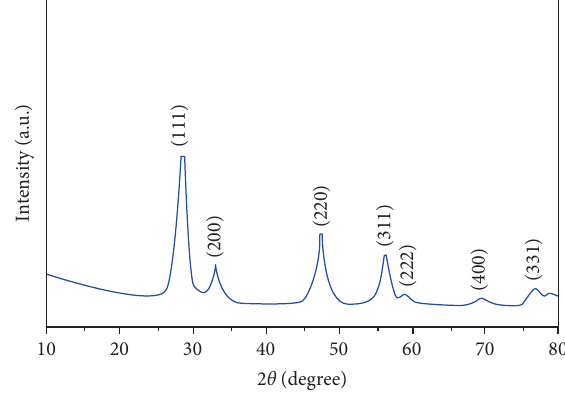
Figure 3: XRD analysis of CeO2 nanoparticles.